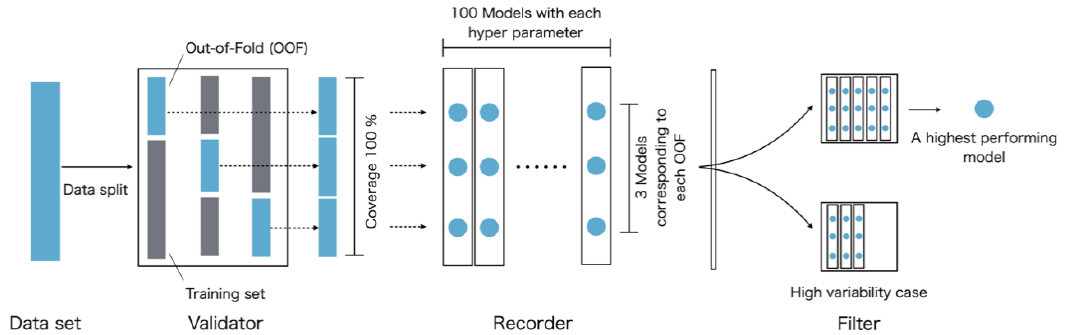
Figure 8. The modeling pipeline integrated validator, recorder, and filter used in this study.